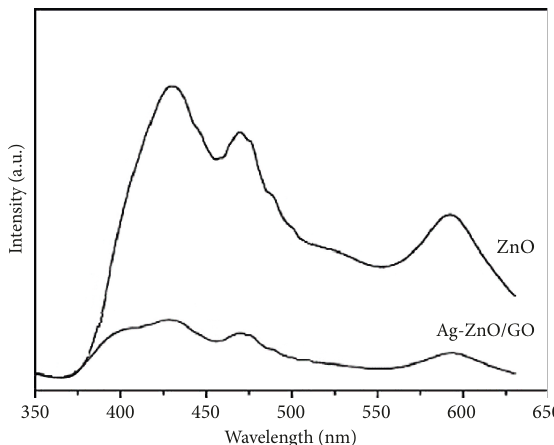
Figure 7: PL spectra of synthesized